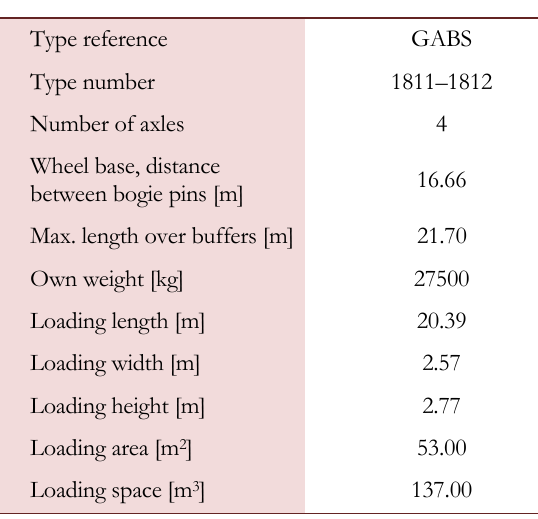
Table 1: Typical specifications for a standard freight “GABS”